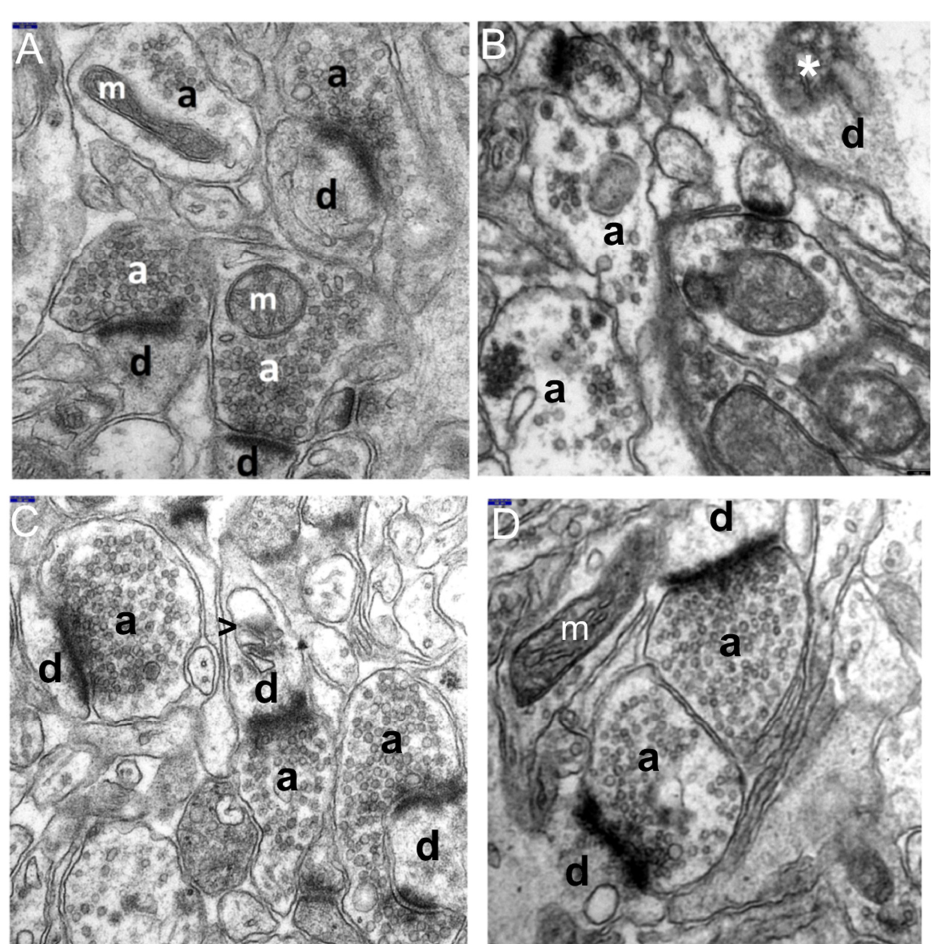
Figure 5. Representative images of EM from different experimental groups ( A —control group; B —FS group; and C , D —TPM + HS group). All images ( A – D ) presented with the same scale bar of 100 nm. ( A ) The elecronogram demon- strates well-preserved neuropil components of the temporal lobe neocortex in the control group. The presynaptic (a) and postsynaptic (d) parts of the synapses are clearly seen, while synaptic active zones are distinct and long, and postsynaptic density was well-preserved (a detailed description below Figure 1). ( B ) The electronogram shows marked swelling and damage to the synaptic endings in the temporal lobe neocortex in the HS group. The presynaptic (a) and postsynaptic (d) parts of synapses are remarkably swollen. Markedly reduced content of synaptic vesicles and their abnormal clumping within the axoplasm can be seen. Within the dendroplasm of dilated synaptic endings, the presence of irregular structures can be seen with a heterogeneous electron density (*) that may correspond to the mitochondrion undergoing necrosis. The length of the synaptic active zones is substantially reduced (a detailed description below Figure 2A,B). ( C , D ) Ultrastructural view clearly demonstrating a neuroprotective effect of TPM on the synaptic endings in the TPM + HS group. Although some of the axonal-end-bulbs (a) are still enlarged, they are filled up with relatively abundant synaptic vesicles evenly distributed within the axoplasm. Within the cytoplasm of a single centrally located dendritic ending, dilated channels of smooth endoplasmic reticulum (>) are visible (Figure 5D). However, the majority of the postsynaptic (d) parts of the synapses show normal ultrastructures. Numerous axodendritic junctions show a marked increase in the length of the synaptic active zone and a relatively well-preserved postsynaptic density; normal mitochondrion (m) can be seen in the synaptic ending (Figure